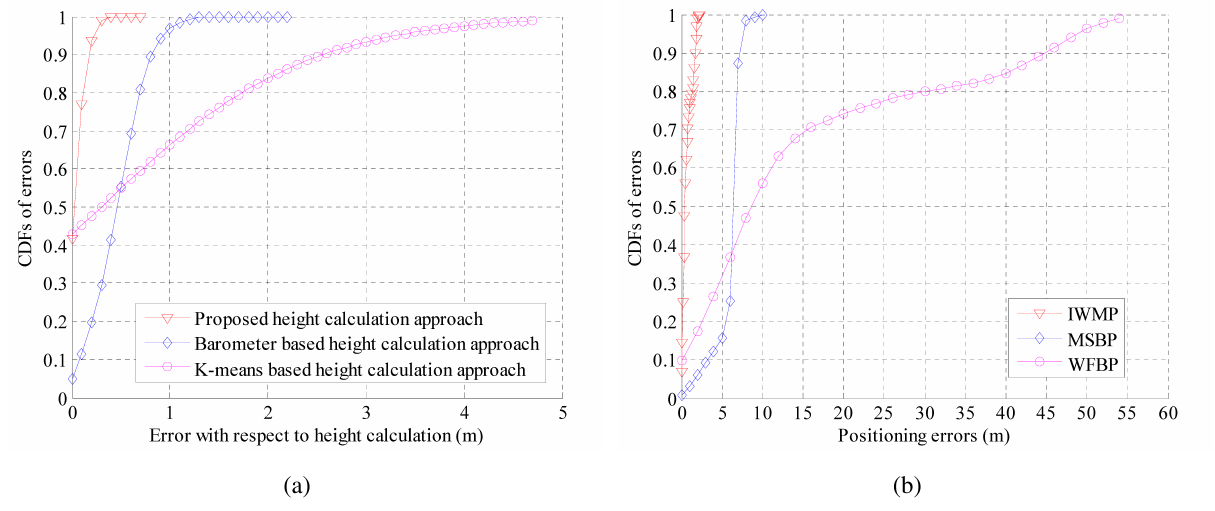
Figure 12. The cumulative distribution functions (CDFs) of errors for height calculation and 3D positioning. ( a ) CDFs of errors for height calculation. ( b ) CDFs of errors for 3D positioning. Table 2. Comparison of positioning accuracy. IWMP, integrated WiFi/MEMS